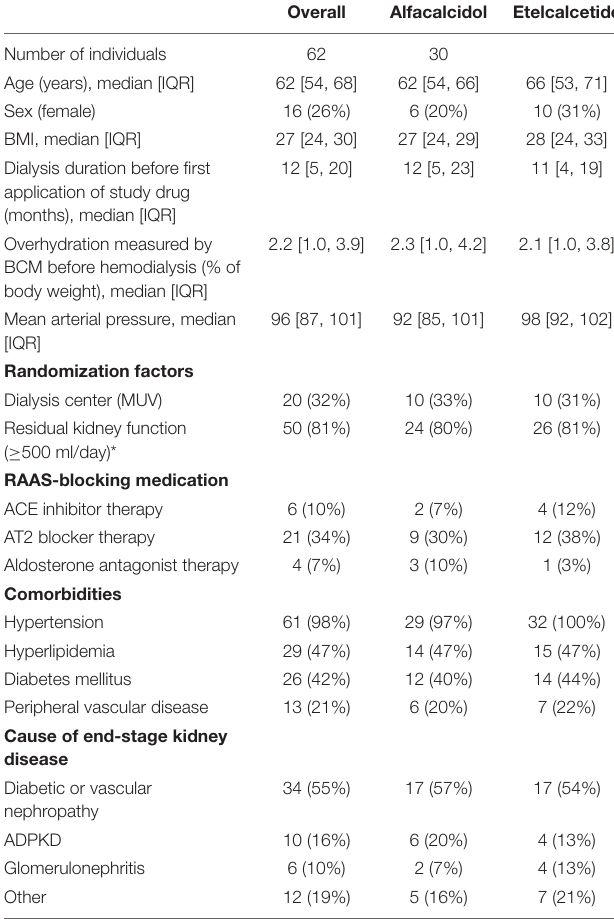
TABLE 1 | Patient characteristics at